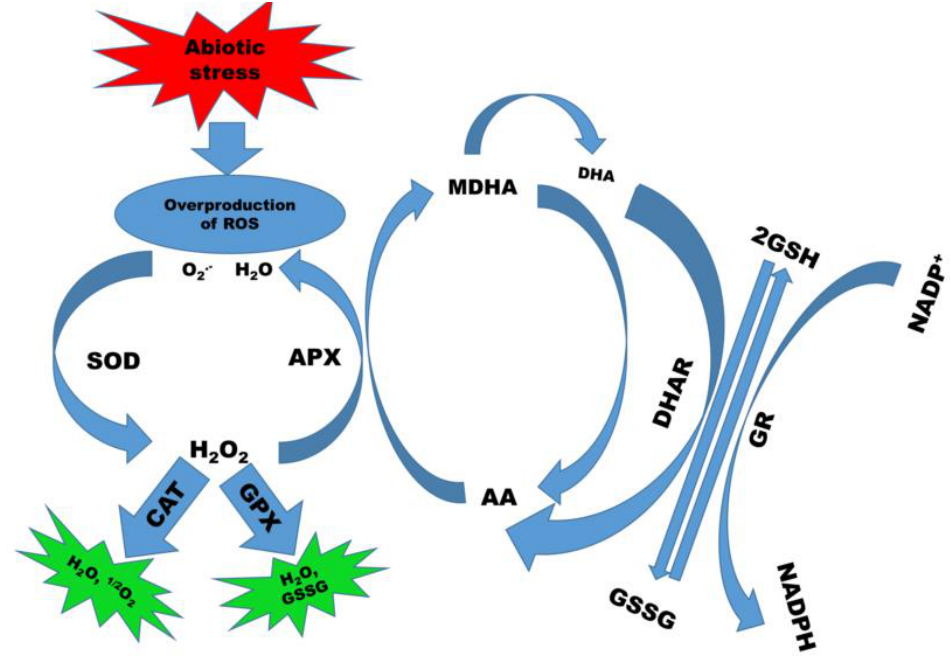
Figure 2. The mechanisms of plant defense systems. Plant antioxidants (superoxide dismutase (SOD), peroxidase (POD), catalase (CAT), glutathione reductase (GR), ascorbate peroxide (APX), etc.) act as